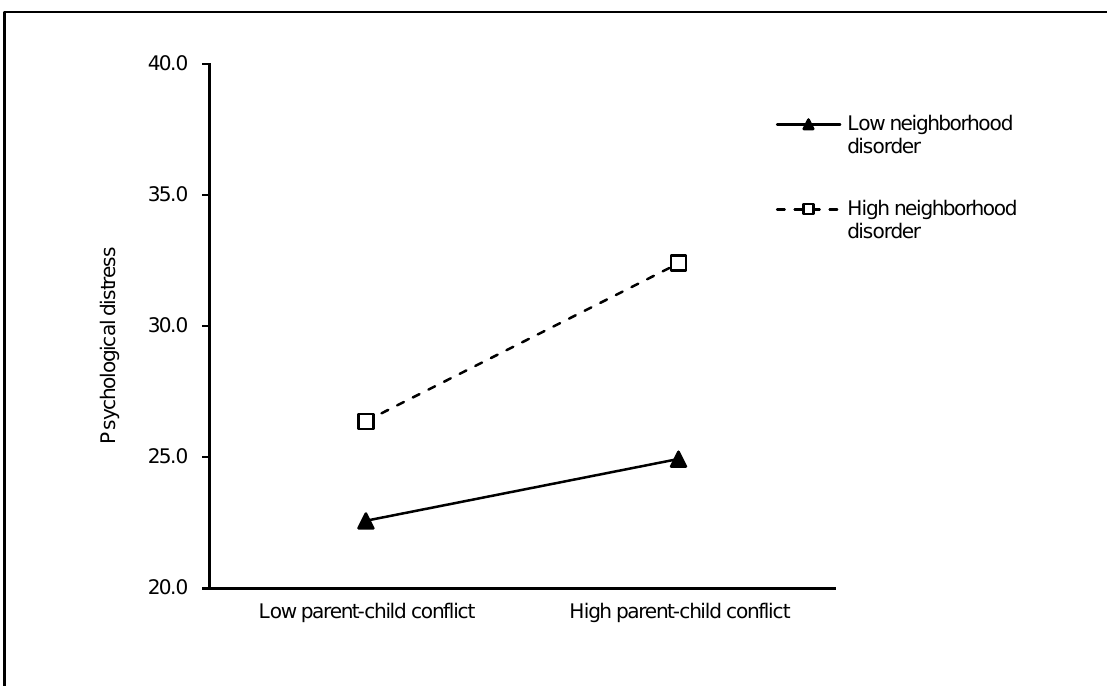
Figure 2. Interaction between parent – child conflict and neighborhood disorder on adolescent psychological distress.